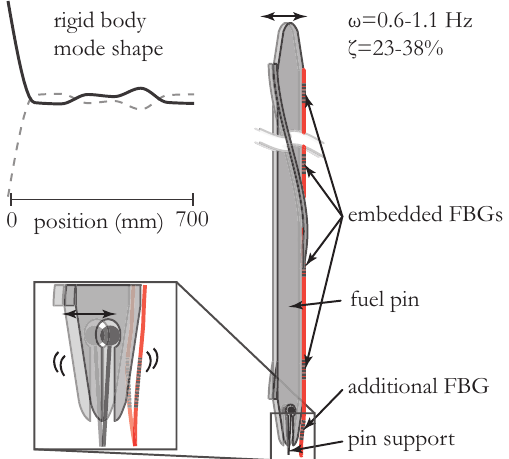
Figure 8. Rigid body “mode shape” occurring as a consequence of the fuel pin fixation or the support structure vibration. The additional FBG located in the capillary measures the relative movement from the fuel pin to its supports. Therefore, only that FBG identifies the rigid body